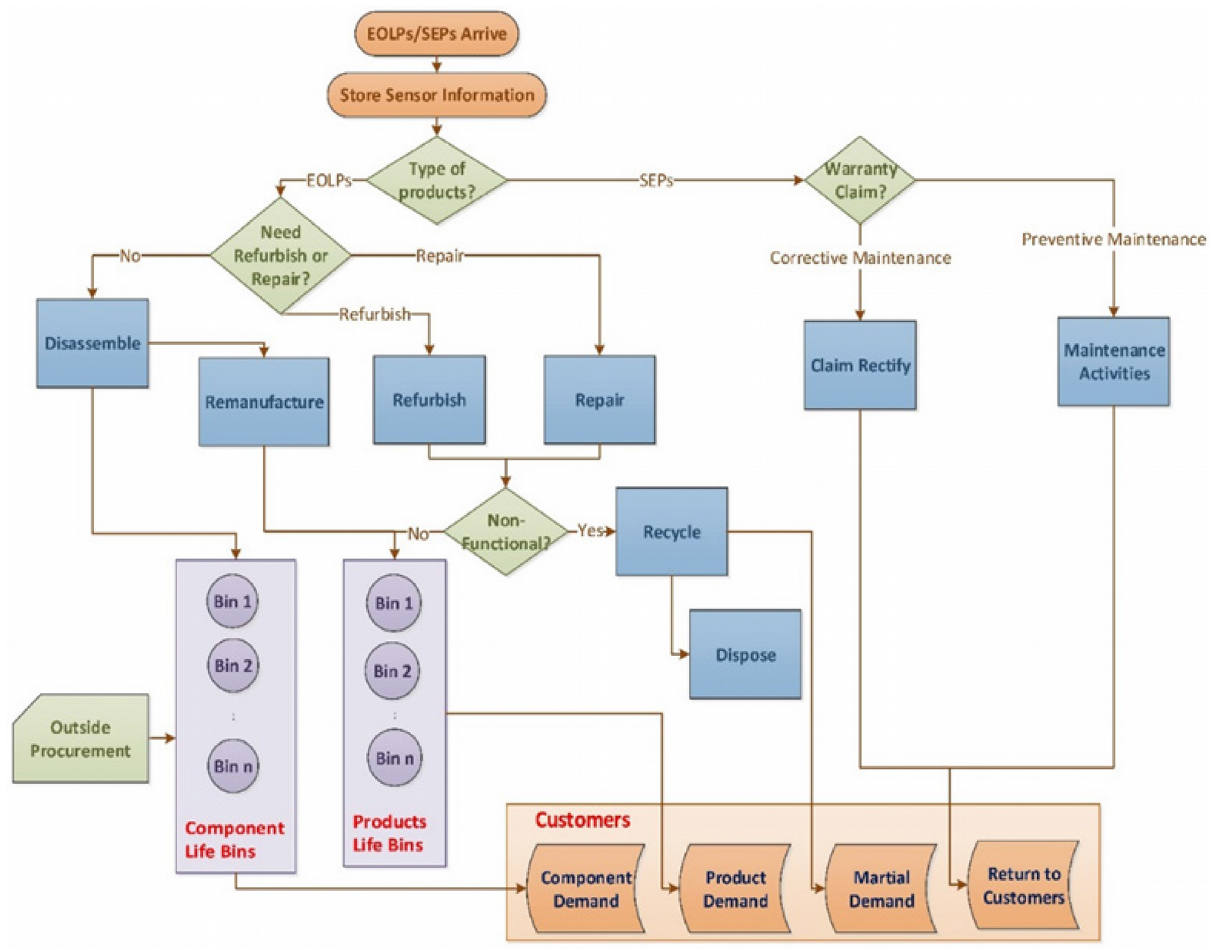
Figure 1. ARTO System’s Recovery